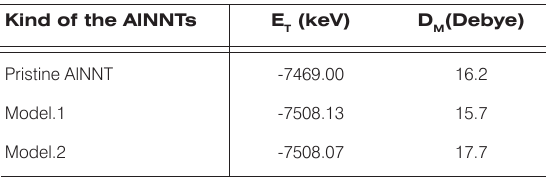
Table 2. Total energy (E ) and dipole moment (D T and O-decorated AlNNTs. Kind of the AlNNTs